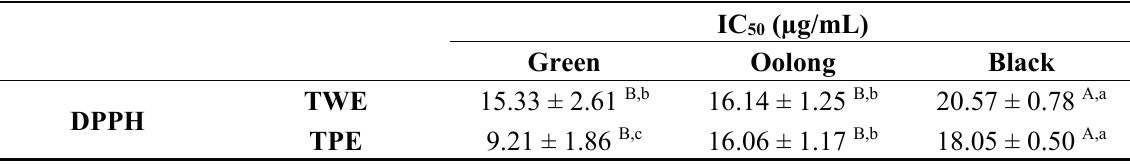
Table 4. Half maximal inhibitory concentration (IC 50 ) of tea water extract (TWE) and tea pomace extract (TPE) of green, oolong, and black tea on the DPPH radical scavenging activity.